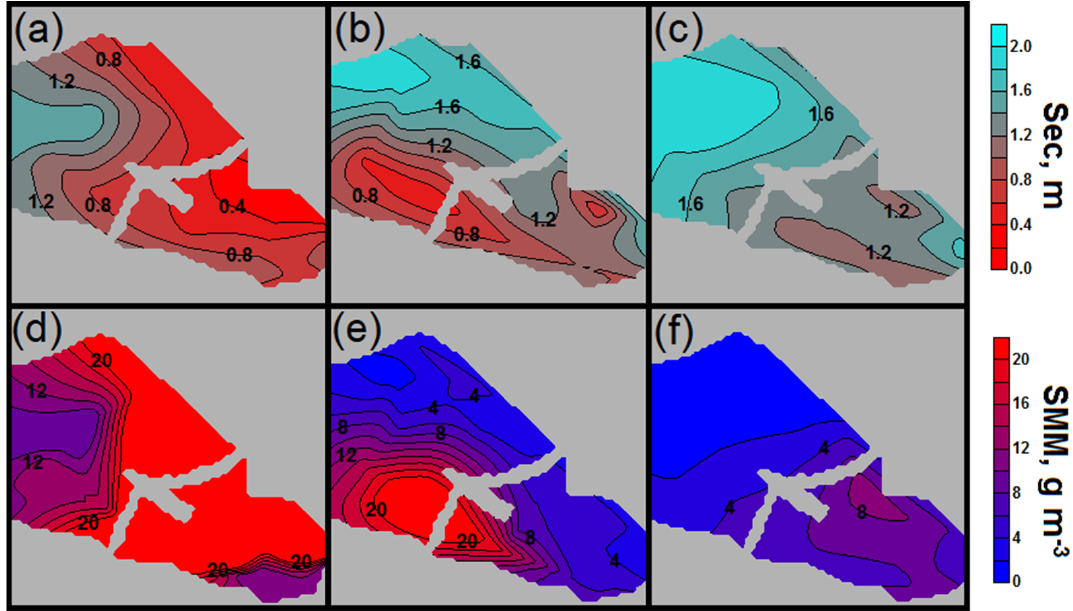
Figure 2. Average Secchi depth during the periods of construction of new port facilities in 2006–2007 ( a ), and in 2014–2015 ( b ), and on average in the 2000s, without data for 2006–2007 and 2014–2015 ( c ), the average concentration of suspended particulate mineral matter in 2006–2007 ( d ) and 2014–2015 ( e ), and on average for the 2000s, without data for 2006–2007 and 2014–2015 ( f ) in the Neva Estuary in midsummer. Sec—Secchi depth; SMM—concentration of suspended particulate mineral matter.